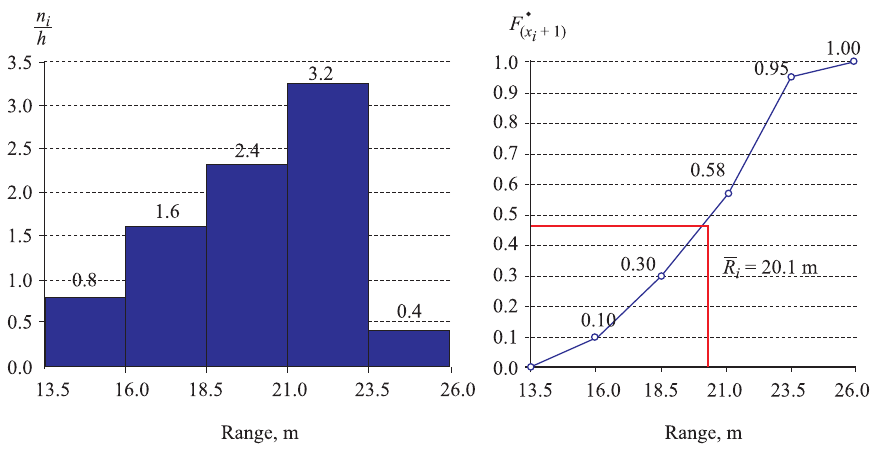
Fig. 3. Absolute frequency histogram and empirical distribution function of the variation in the outer radius of small